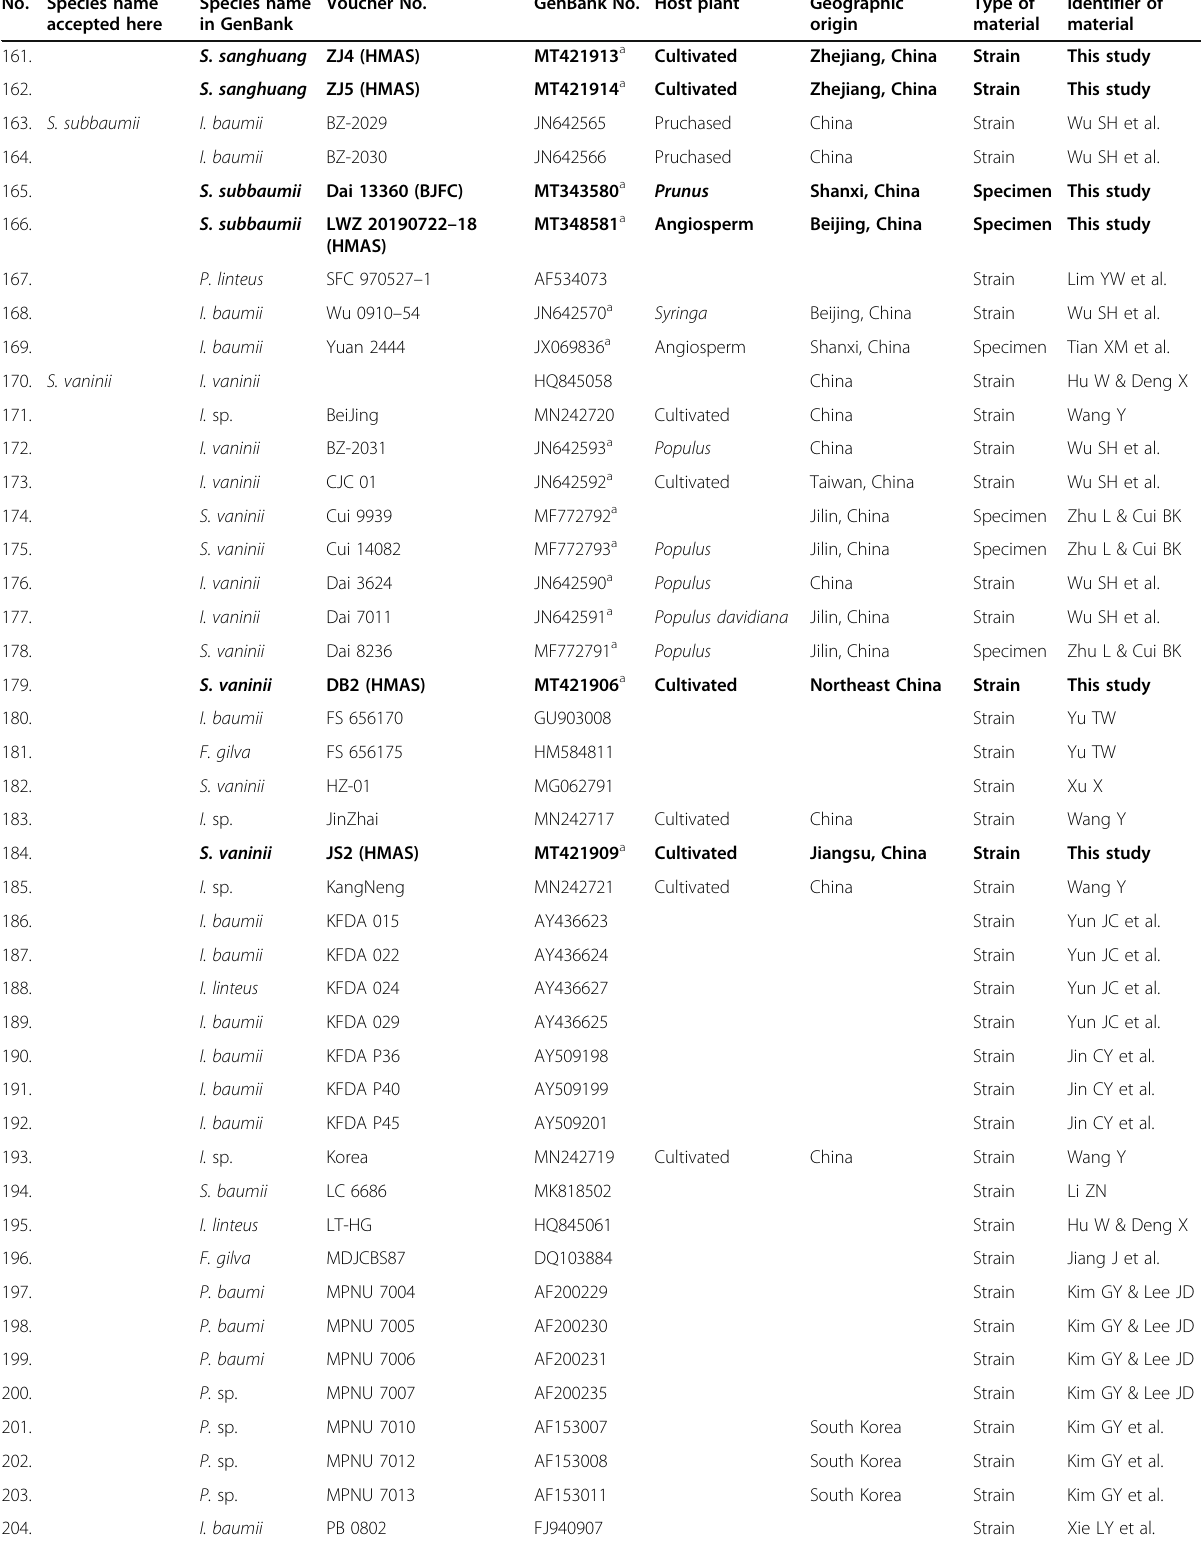
Table 1 Information of analyzed ITS sequences of Sanghuangporus